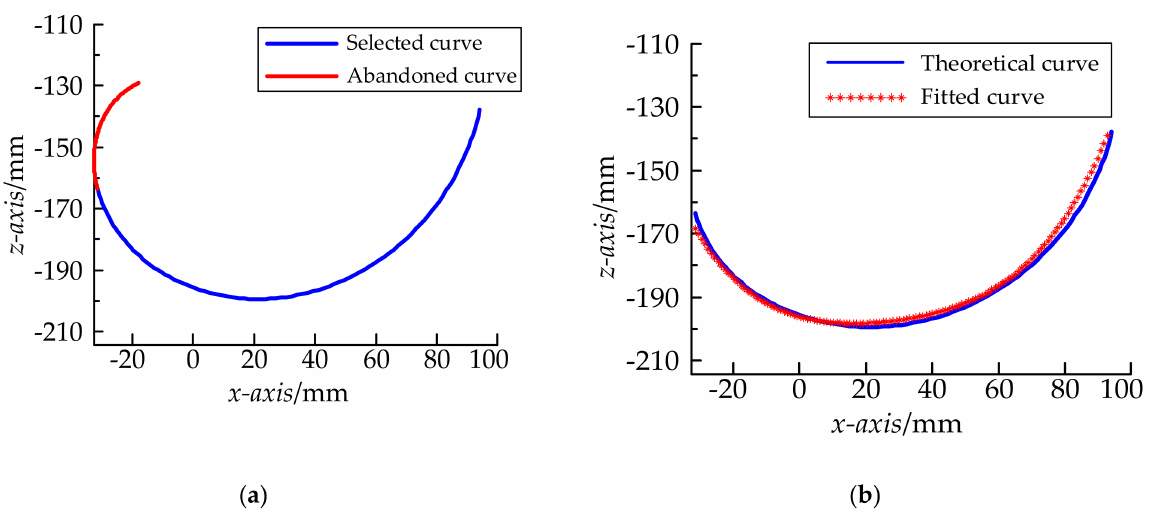
Figure 4. ( a ) Trajectory constraint curves and its trade-offs of the cam structure; ( b ) fitted curve of the